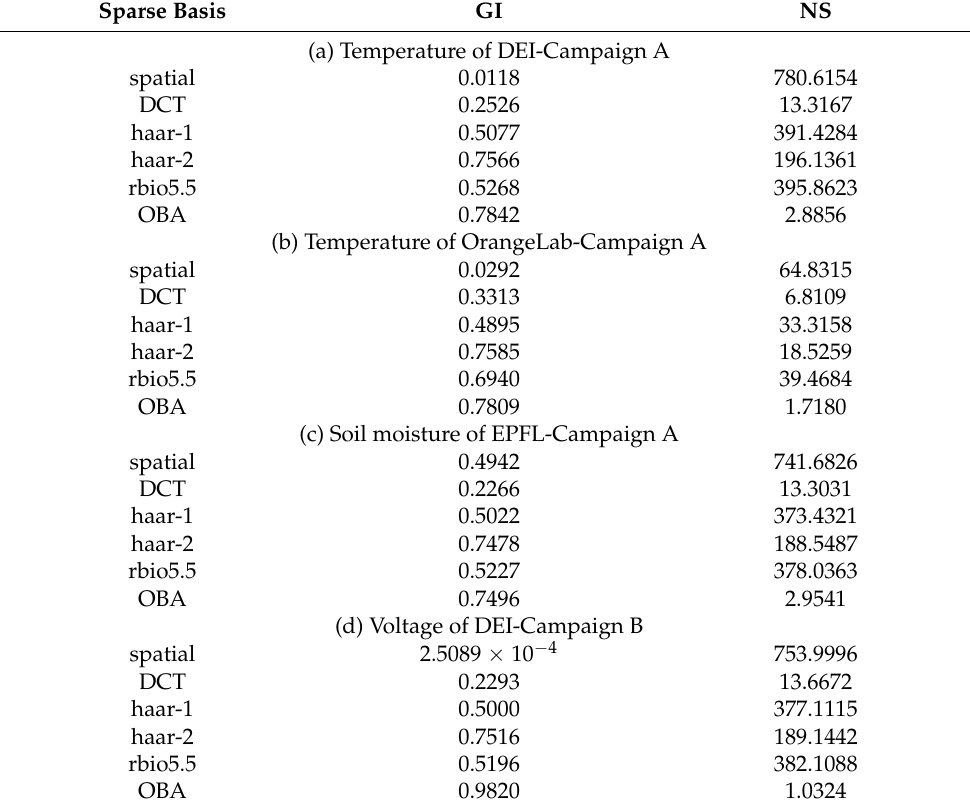
Table 3. Performance evaluations of different sensory